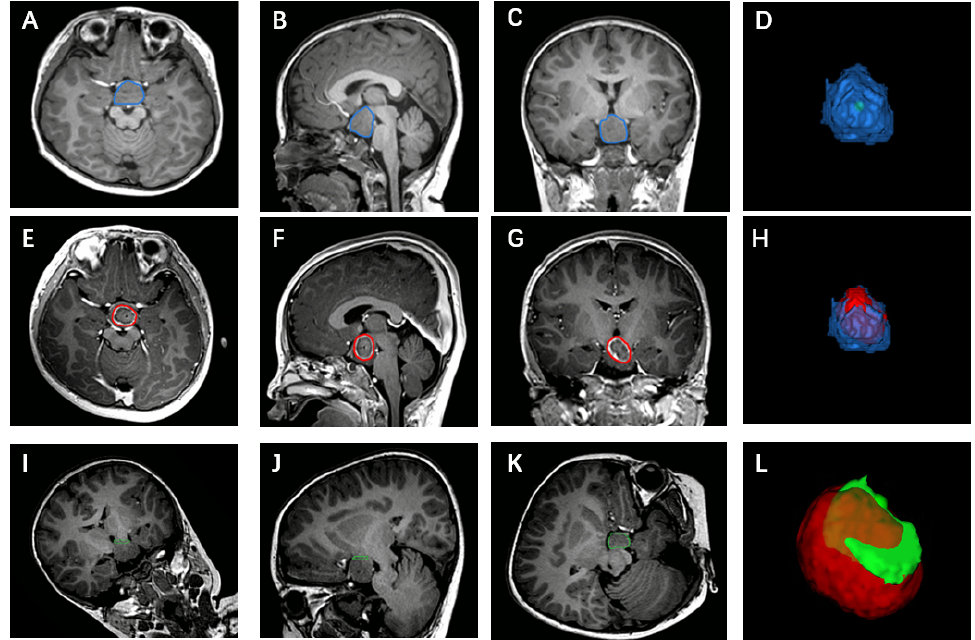
Figure 1. ( A – D ) The construction of the HH body. ( D ): The constructed 3D model of HH body. ( E – H ) The construction of the ablation area. ( H ): The 3D model of ablation area and HH body. ( I – L ) The construction of the border between HH and normal brain tissue. ( L ): The 3D model of the border and ablation area. The circled area was manually outlined to constructed 3D model.